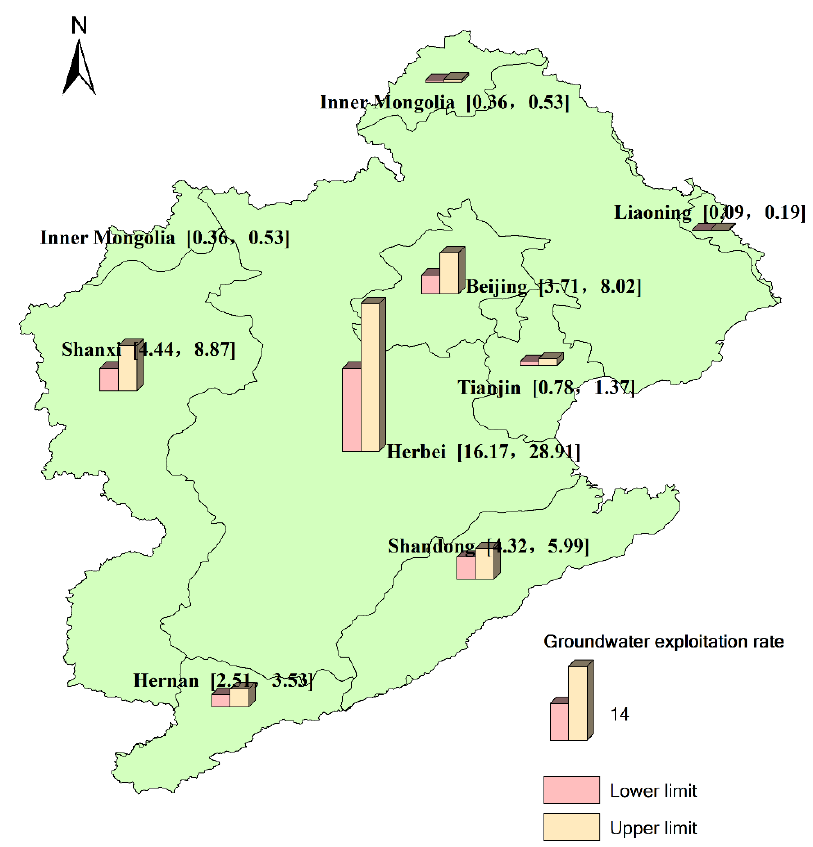
Figure 7. Optimization results of the groundwater exploitation range in the Haihe River Basin (10 8 m³).